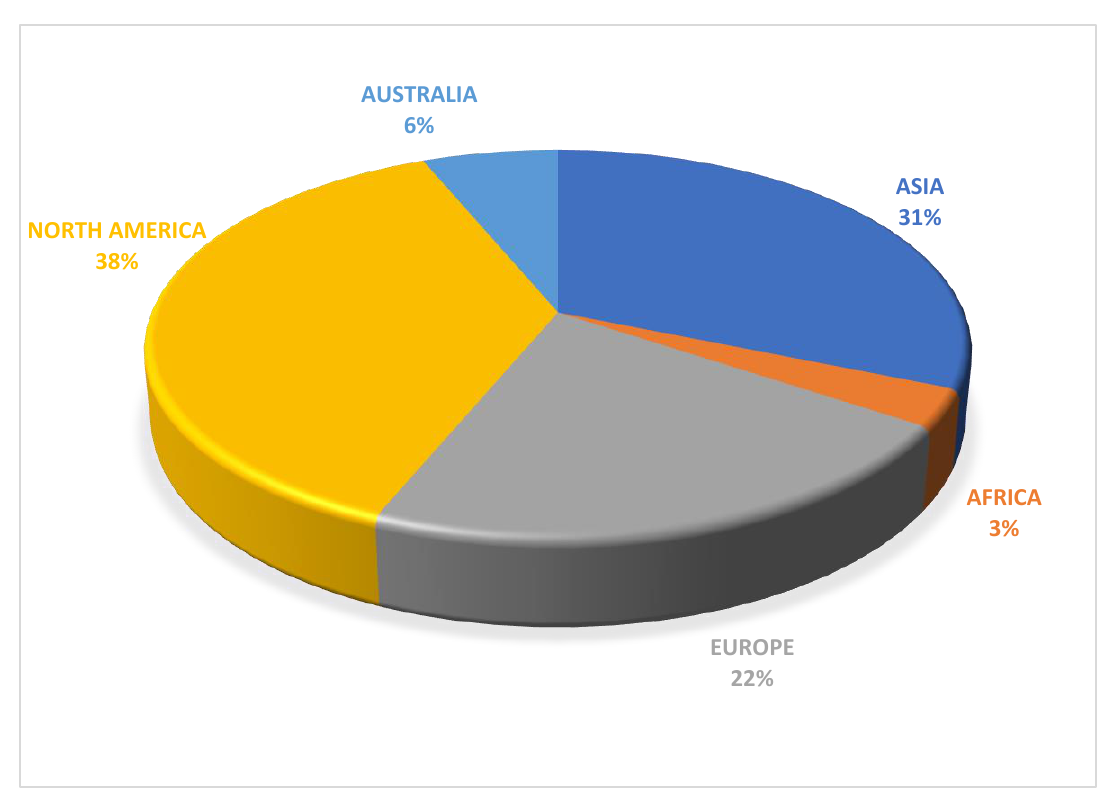
Figure 2. Summary of continents selected for the review.